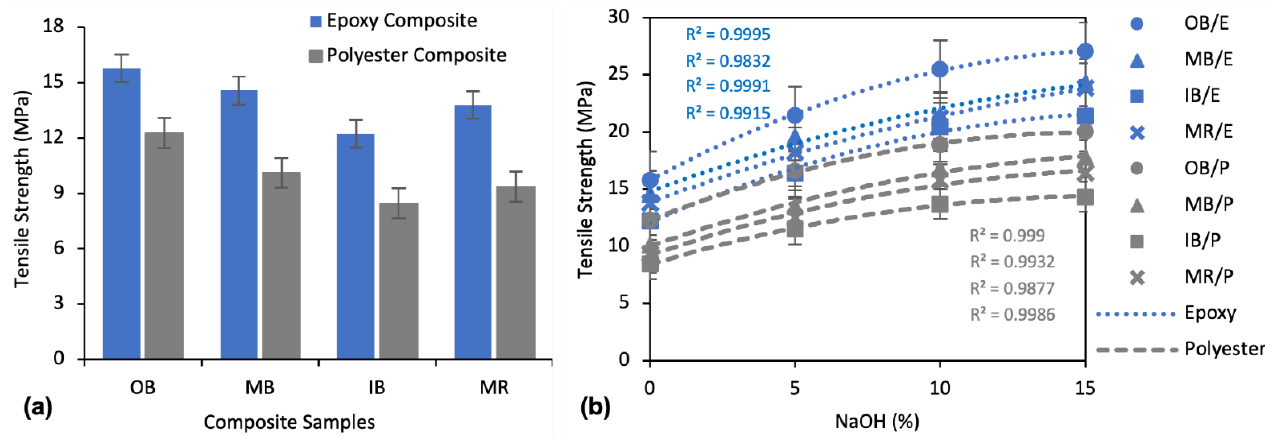
Figure 9. ( a ) Tensile strength of untreated (0% NaOH) composites; ( b ) Effect of alkali treatment on the tensile strength of the composites.